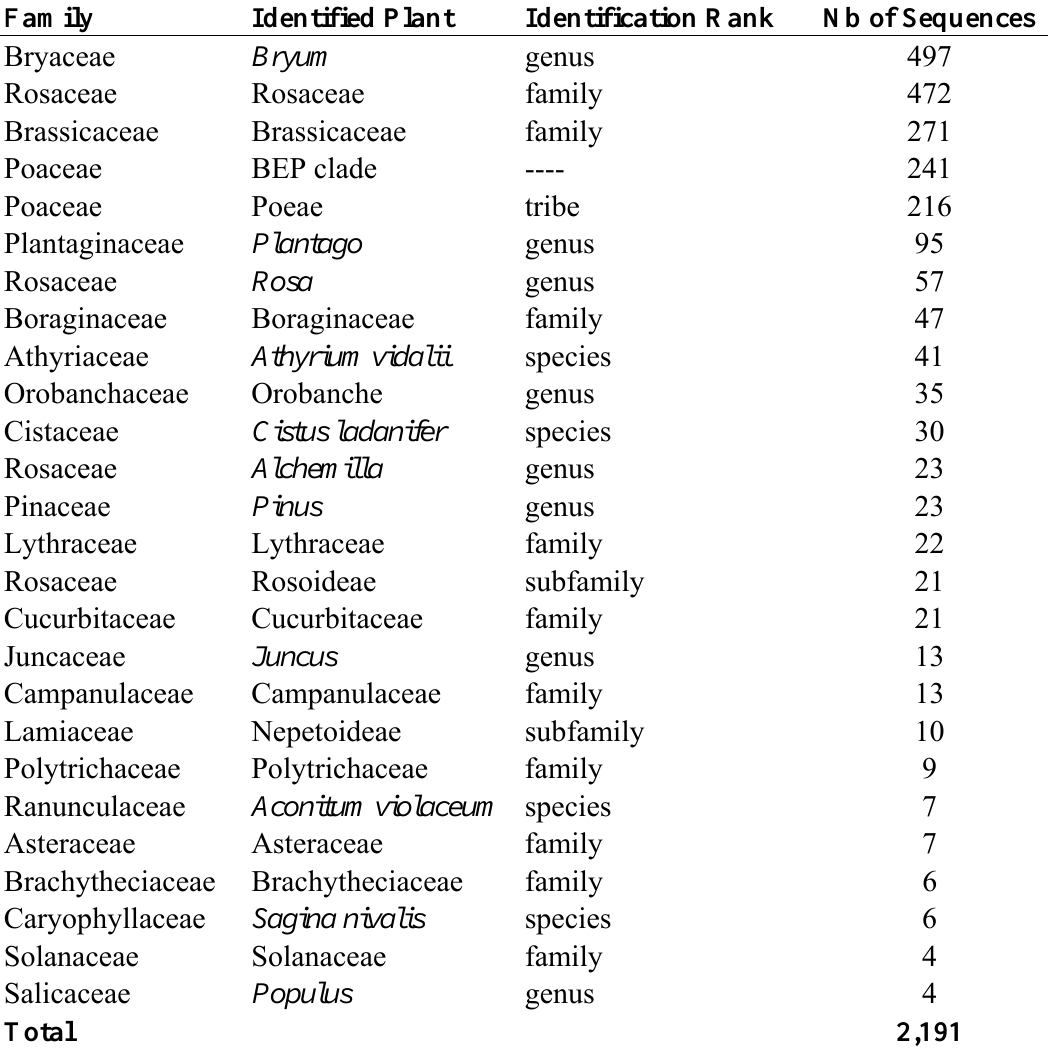
Table 2. Plant taxa identified in the Wild Flower